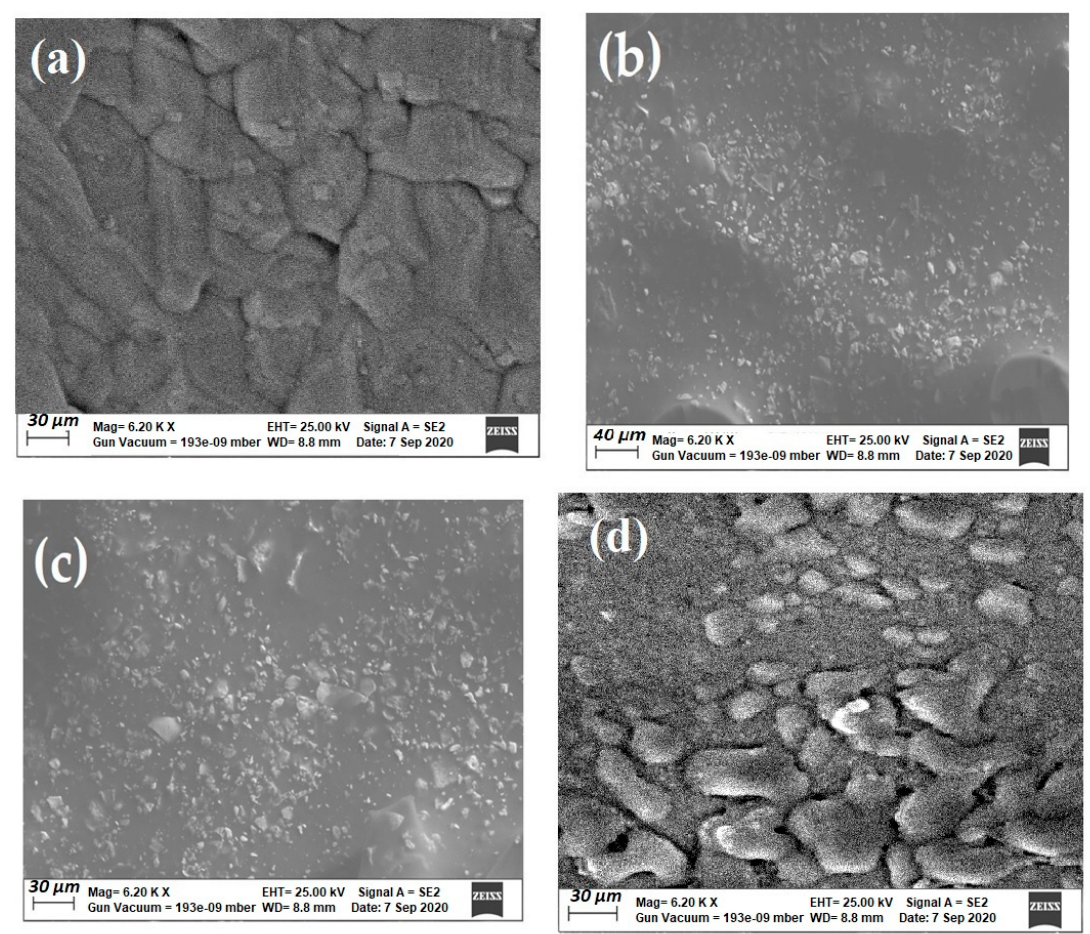
Figure 3. DLS data of ( a ) ZrO 2 NPs and ( b ) Cr 2 O 3 NPs in 1 mM KCl aqueous solution at 25 °C.